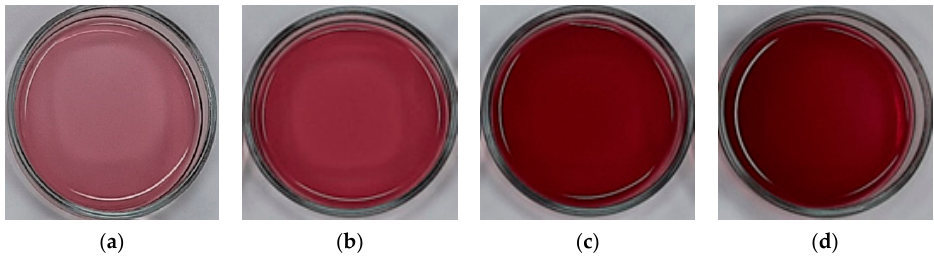
Figure 2. Visual appearance of samples: ( a ) fresh calafate juice; ( b ) cycle 1; ( c ) cycle 2; and ( d ) cycle 3.